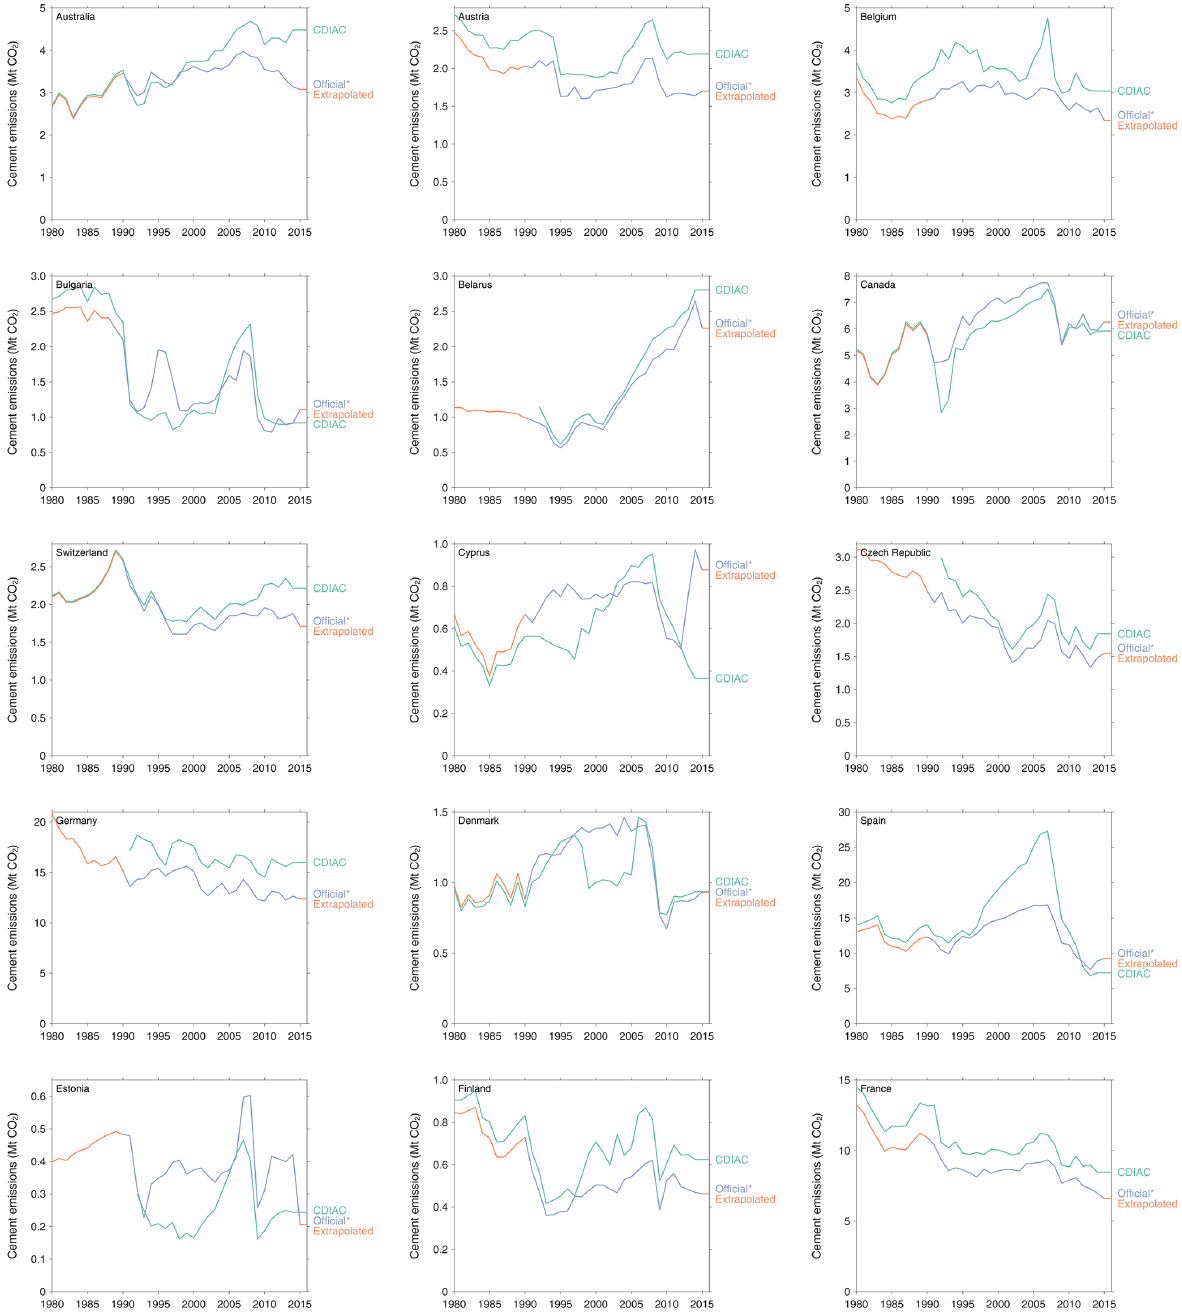
Figure D1. Revised cement emissions for Annex I parties to the UNFCCC.